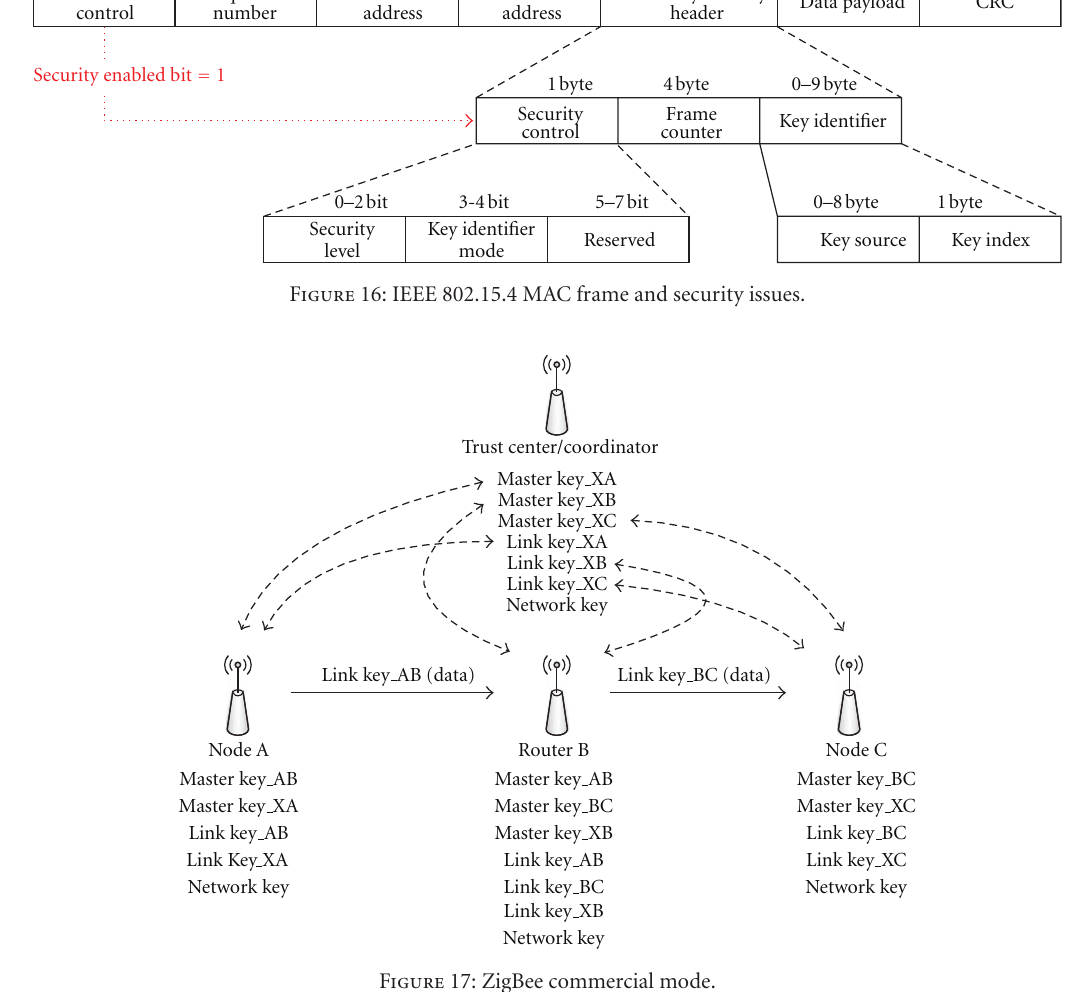
Figure 17: ZigBee commercial